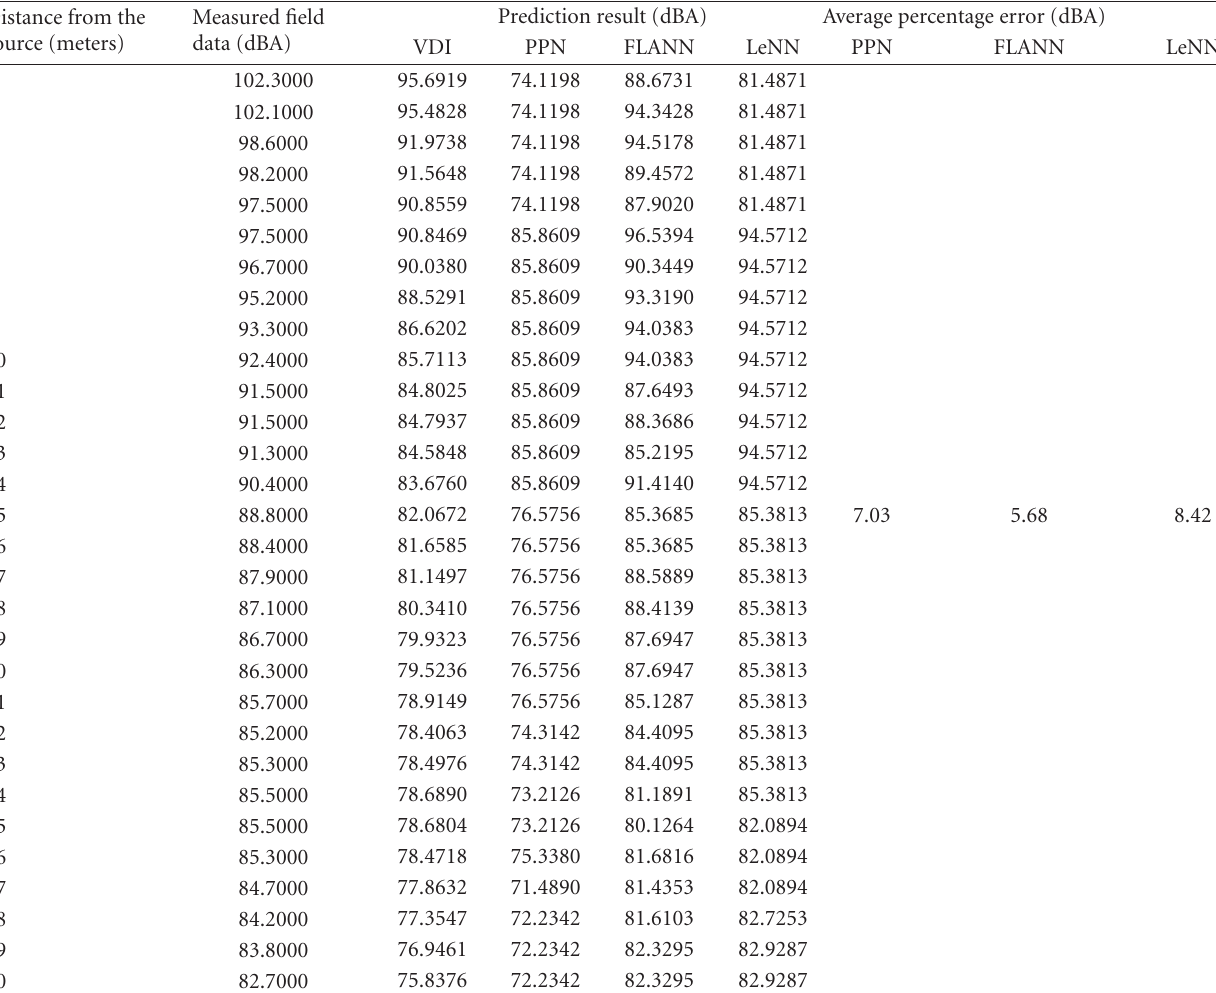
Table 1: Simulation study of shovel